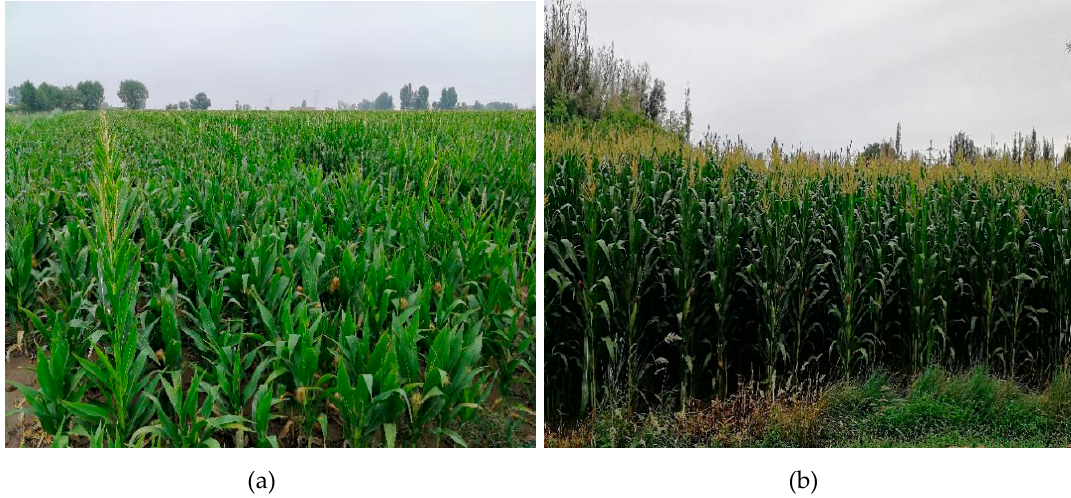
Figure 5. The photos of ( a ) seed maize with parents and mothers regularly planted alternately;( b ) common maize, which is planted with the same hybrid variety.